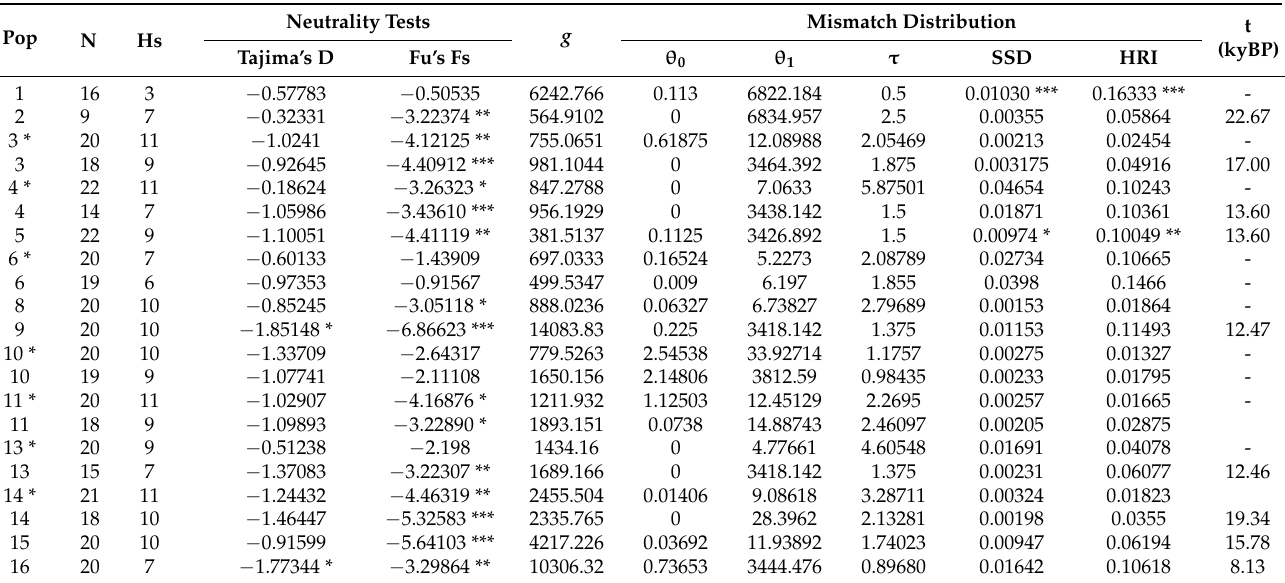
Table 1. Cyt-b-based historical demographic indices of 14 populations and demographic expansion time estimations for 9 populations based on tau